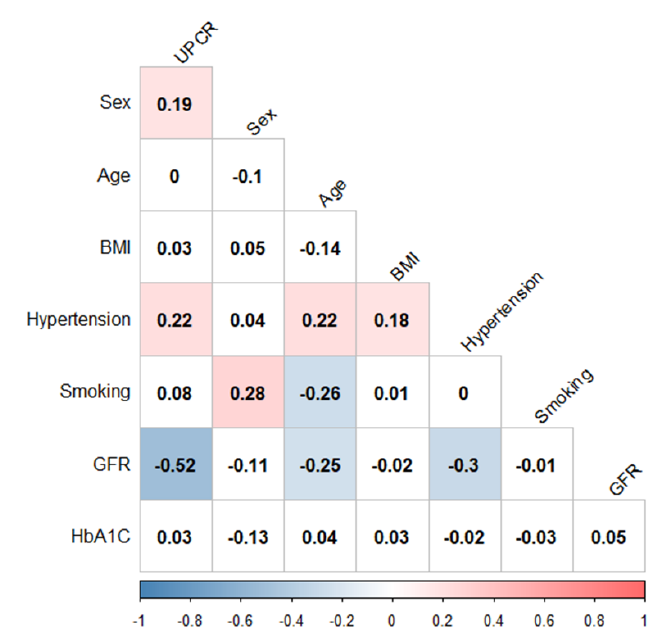
Figure 2. Spearman correlation plot of clinical characteristics in diabetic nephropathy (DN) patients. Significant positive and negative correlations ( p < 0.01) are shown in red and blue, respectively. Spearman’s correlation coefficients are shown in wells. UPCR: urine protein and creatinine ratio; BMI: body mass index; GFR: glomerular filtration rate; HbA1C: hemoglobin A1c.